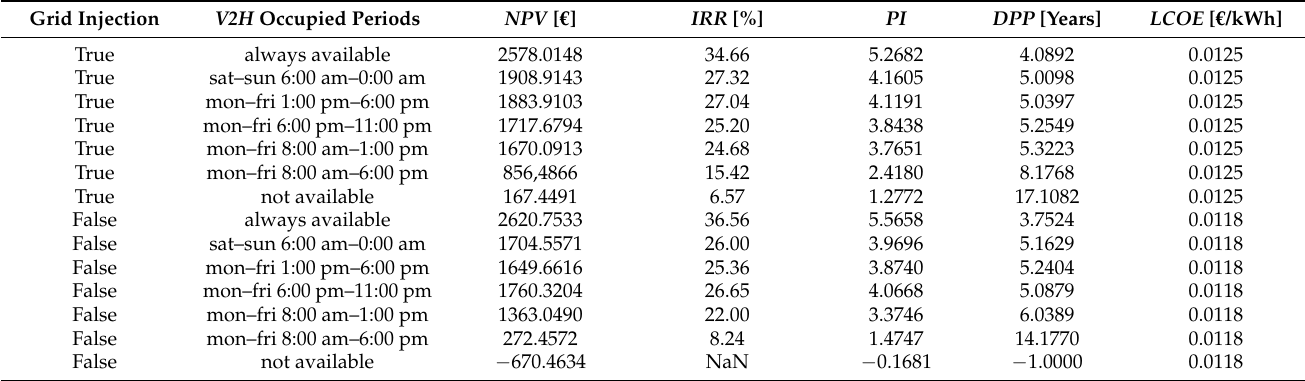
Table 6. Economical results for 0.75 kWp PV setup.